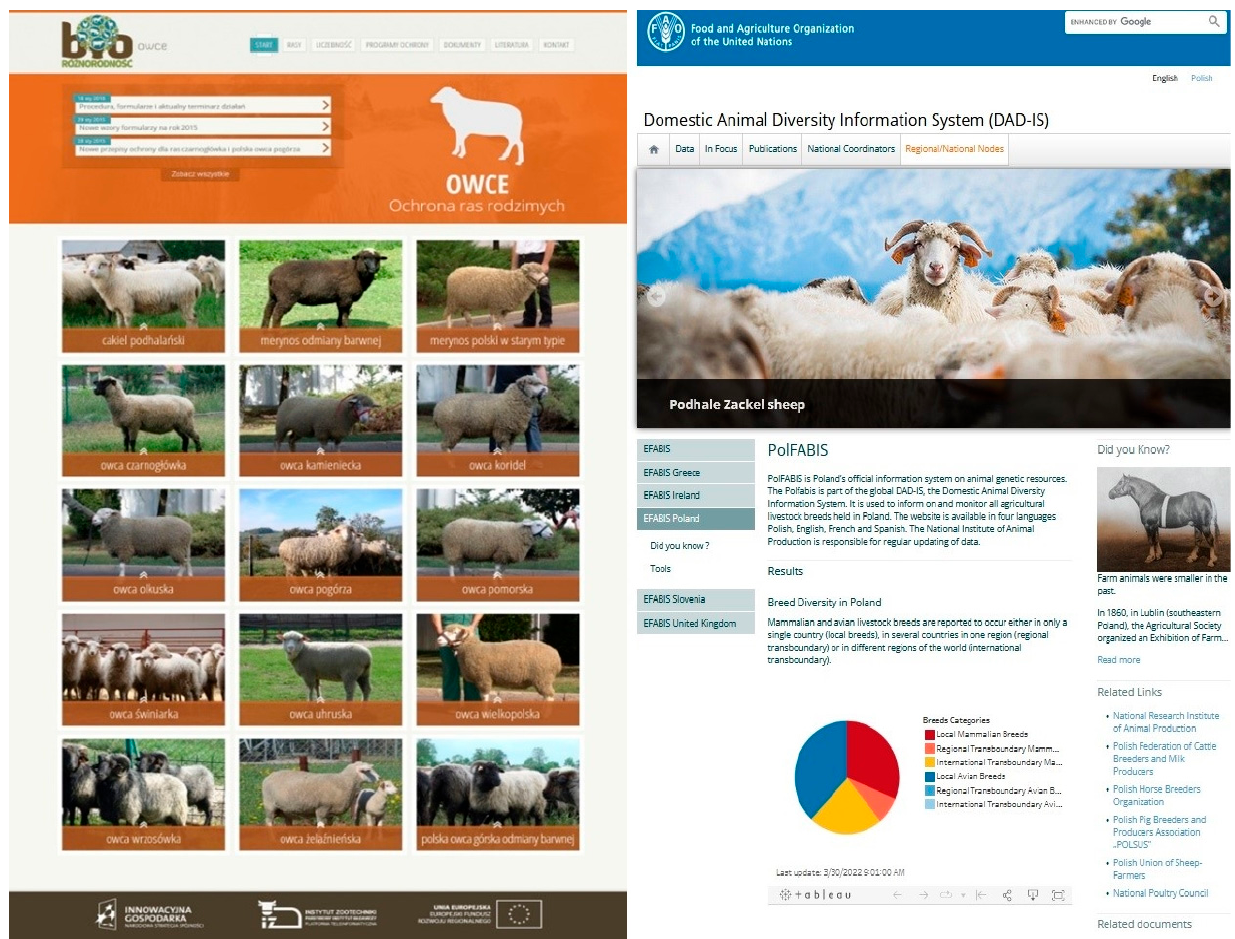
Figure 2. NRIAP biodiversity website - native breeds of sheep in Poland (http://owce.bioroznorodnosc.izoo.krakow.pl/, accessed on 1 March 2022) and Polish EFABIS website (https://www.fao.org/dad-is/regional-national-nodes/efabis-pol/en/, accessed on 1 March 2022).